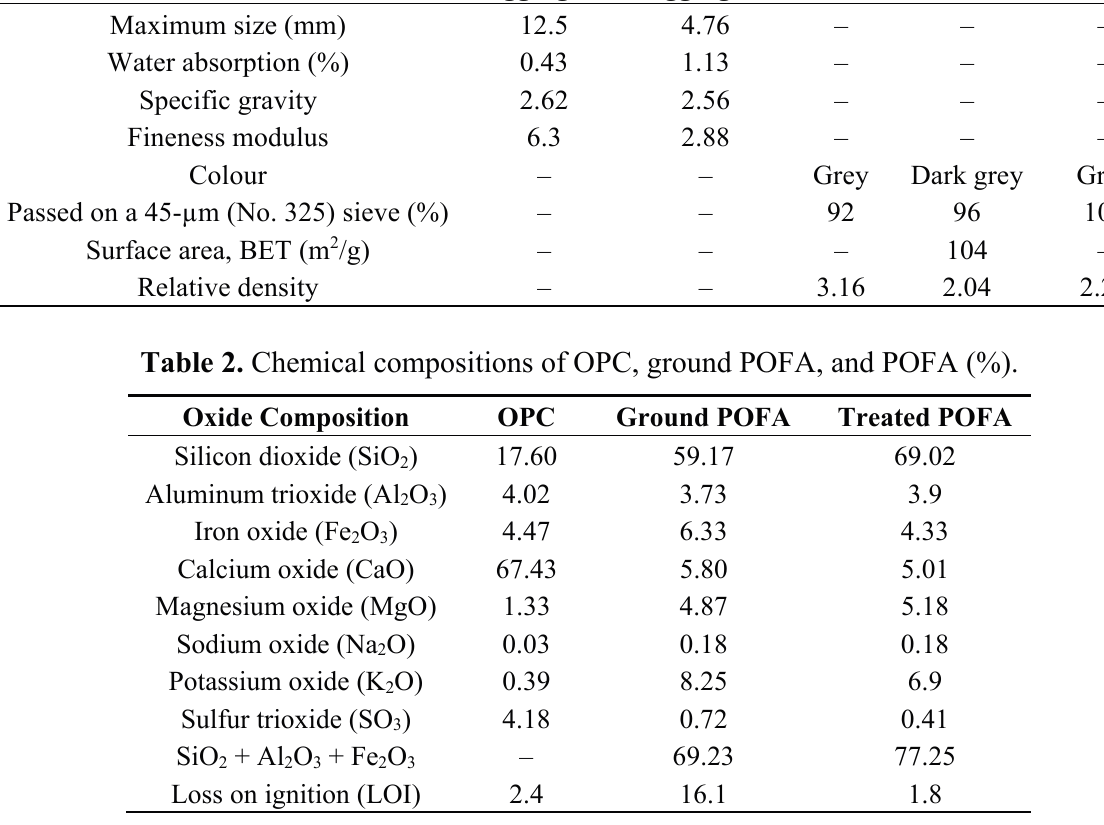
Table 1. Physical properties of aggregate, Ordinary Portland cement (OPC), ground Palm oil fuel ash (POFA), and treated POFA. BET means Brunauer–Emmett–Teller. Coarse Property